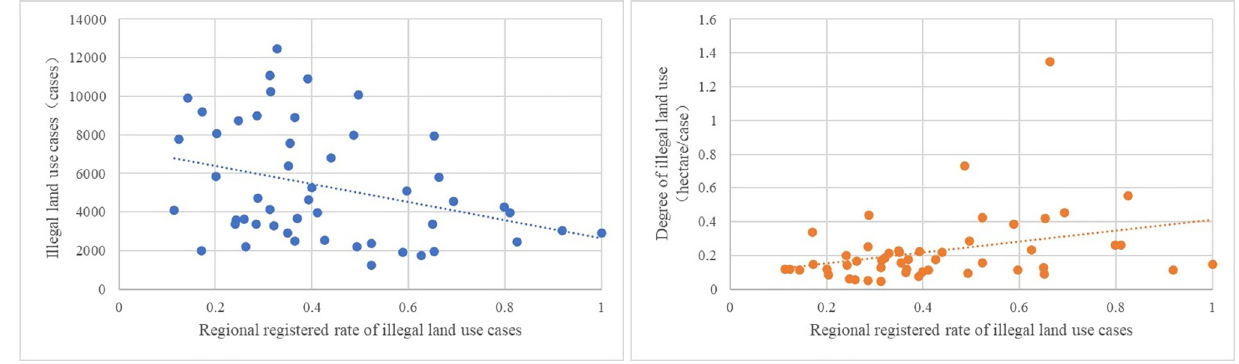
Fig 4. Land law enforcement strength and illegal land use.